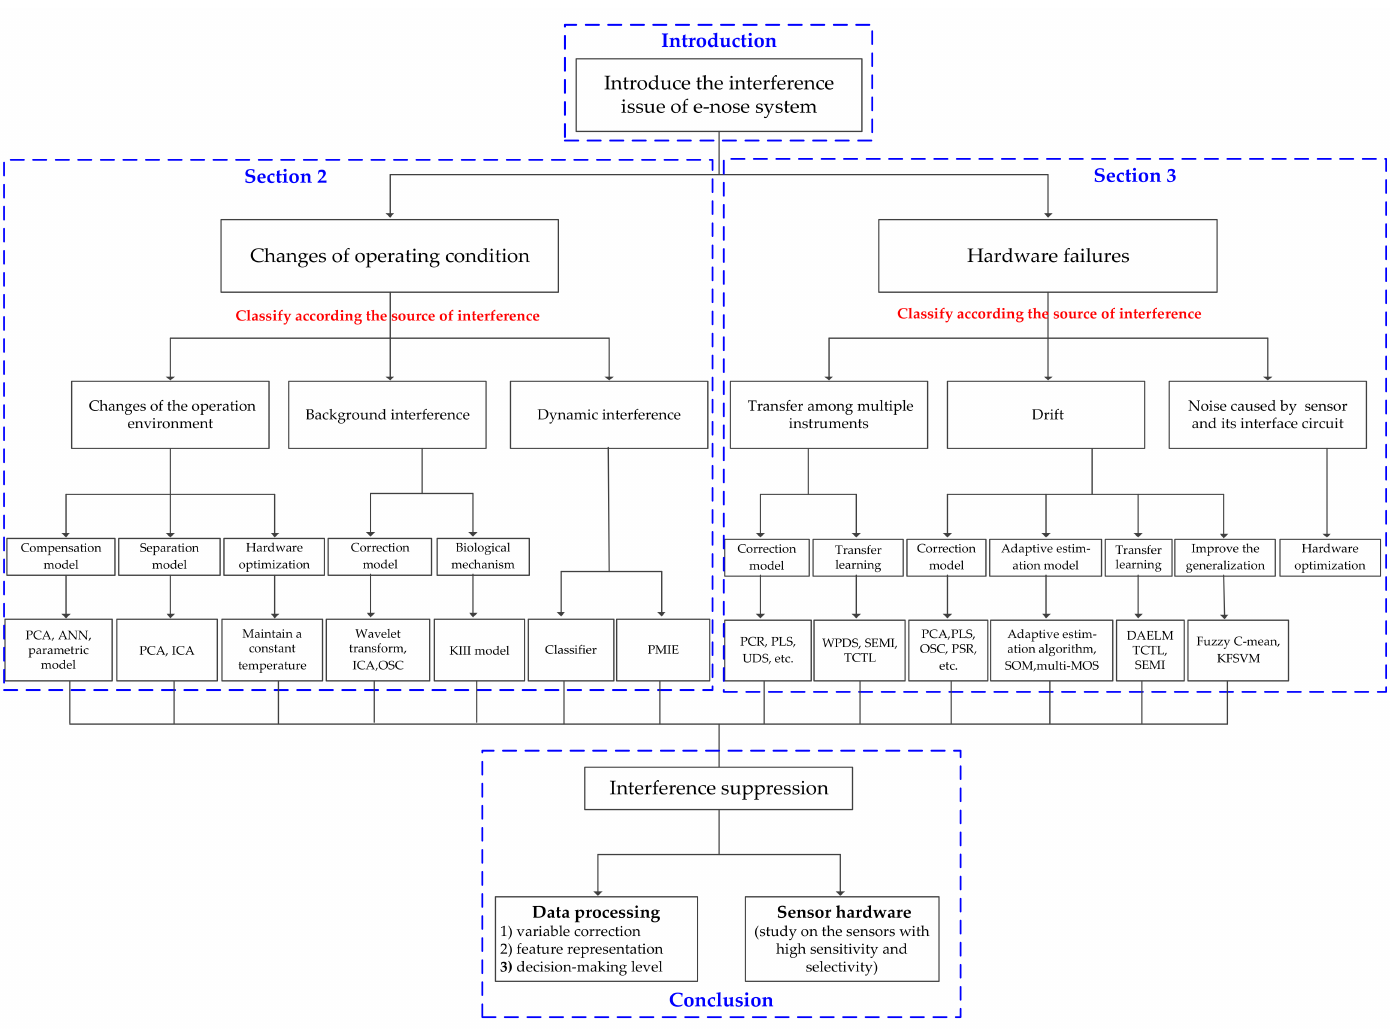
Figure 2. Overall structure of the